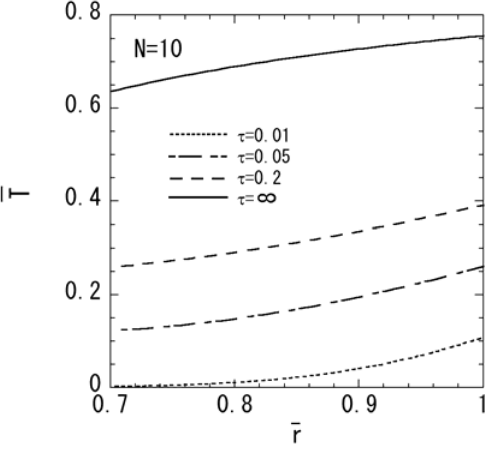
Figure 1. Variation of the temperature change (